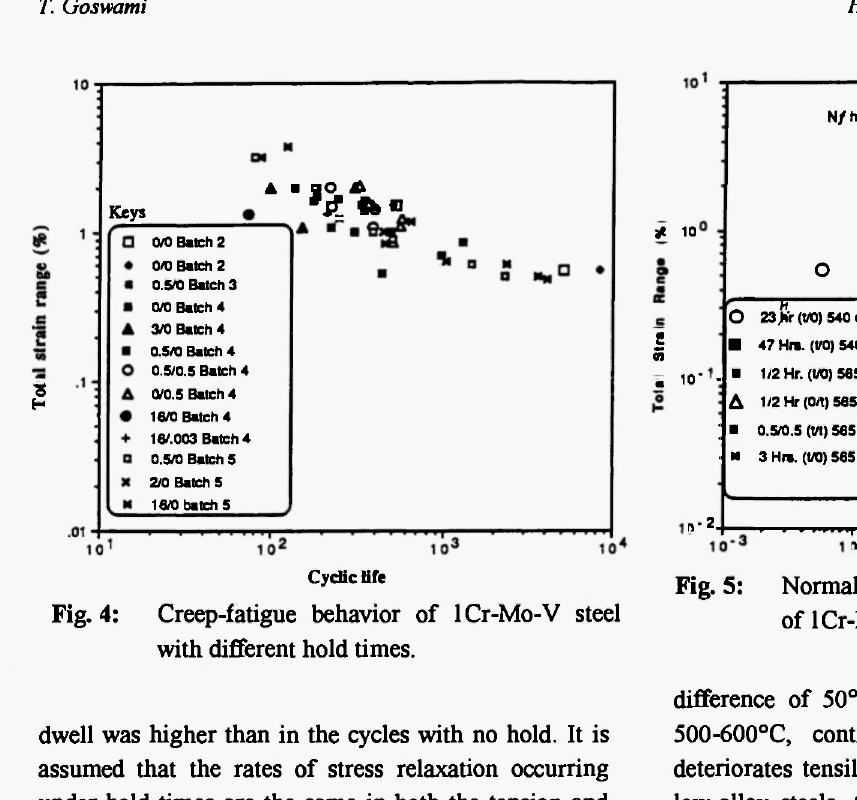
Fig. 5: Normalized life ratio of various dwell cycles of lCr-Mo-V